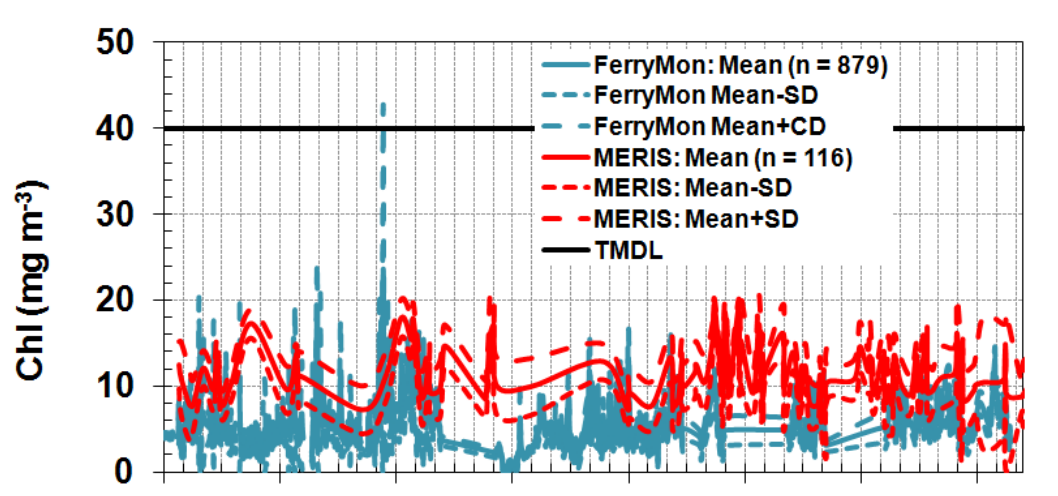
Figure 7. The seasonal dynamics (2006–2009) of the measured FerryMon and predicted MERIS daily-averaged Chl for the